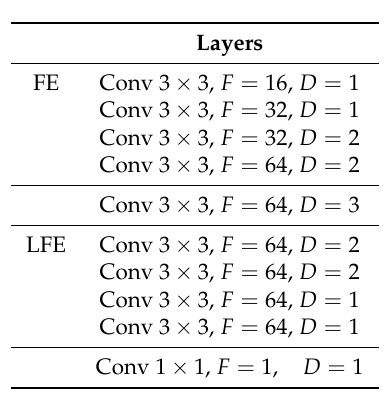
Table 1. Detailed architecture of the proposed network inspired by [41], where F is the number of filters and D is the dilation factor to perform dilated convolutions. It is possible to notice the symmetric structure of the dilations whose factor increases in the Front End (FE) module, allowing us to increase the receptive field, and decreases in the Local Feature Extraction (LFE) module, aggregating local features to obtain spatial consistency in the output map. Note that each convolutional layer is followed by batch normalization (except the last layer) and ReLU activation